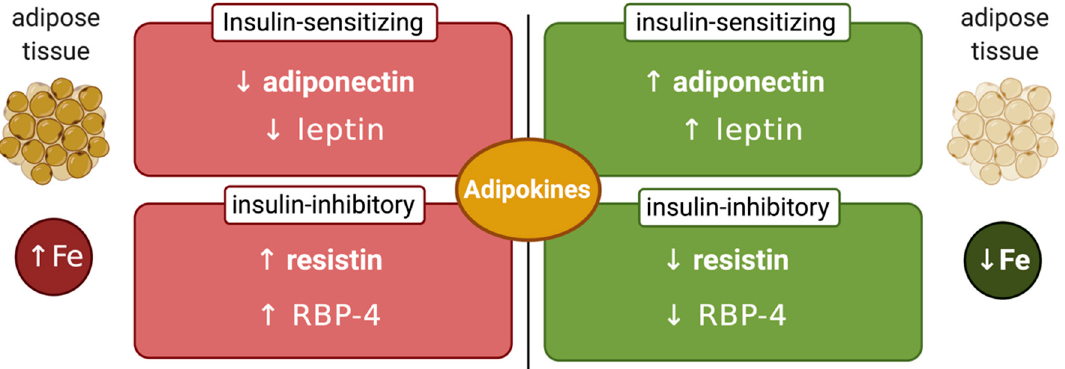
Figure 3. Iron-dependent regulation of adipokines. Increased adipose tissue iron levels inhibit insulin-sensitizing adiponectin and leptin and stimulate insulin-inhibitory resistin and retinol-binding protein 4 (RBP-4). Conversely, reduced adipose tissue iron levels stimulate insulin-sensitizing adiponectin and leptin and inhibit insulin-inhibitory resistin and RBP-4.